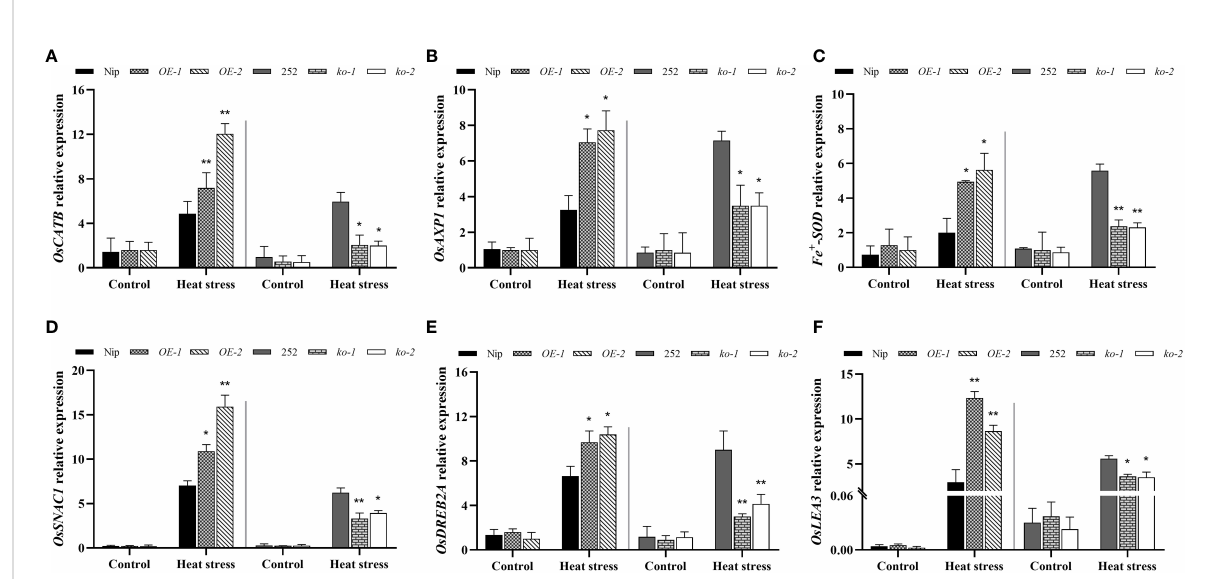
FIGURE 5 Transcriptional expression of antioxidant and defense related genes in seedlings of WT and transgenic lines under heat stress. Three antioxidant genes transcript levels of OsCATB (A) , OsAXP1 (B) , and Fe + SOD (C) . Seedlings of WT and transgenic lines were subjected to heat stress at 45°C for 48 h, and leaves were harvested for RNA extraction, cDNA synthesis and RT-qPCR analysis. For each RT- qPCR, rice reference gene OsActin1 was used as a control to detect its transcript levels in different samples. Data are means ± SD (n = 3; *P < 0.05, **P < 0.01, Student ’ s t - test). Three defense genes transcript levels of OsSNAC1 (D) , OsDREB2A (E) , and OsLEA3 (F) . Data are means ± SD (n = 3; *P < 0.05, **P < 0.01, Student ’ s t